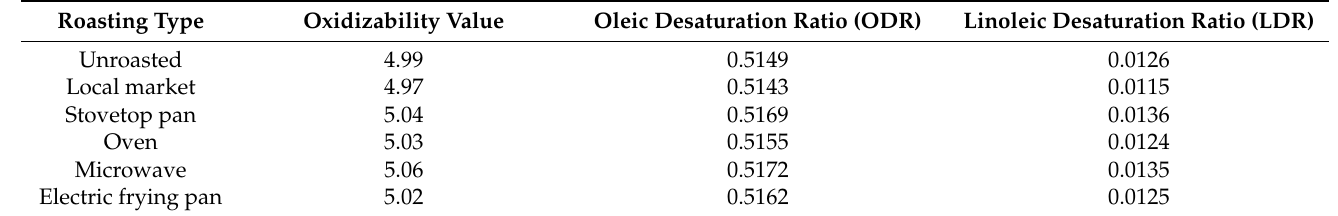
Table 4. Oxidizability, ODR, and LDR indices for oil recovered from sesame seeds roasted by different